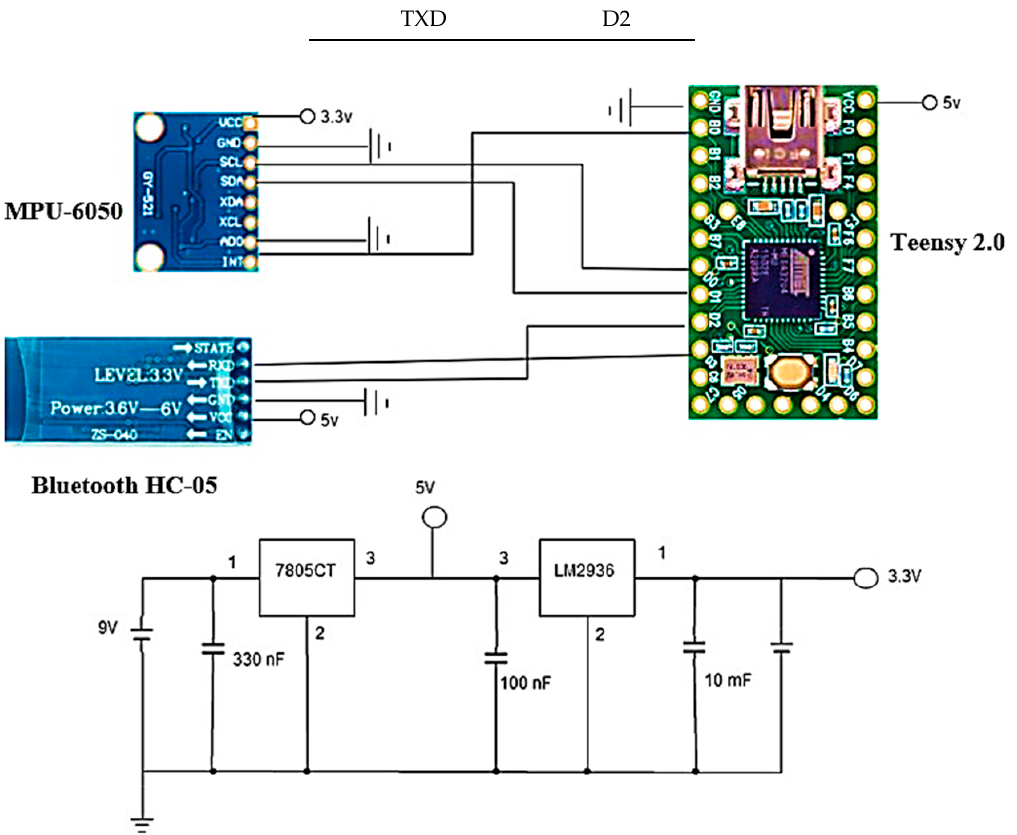
Figure 3. Connections diagram.